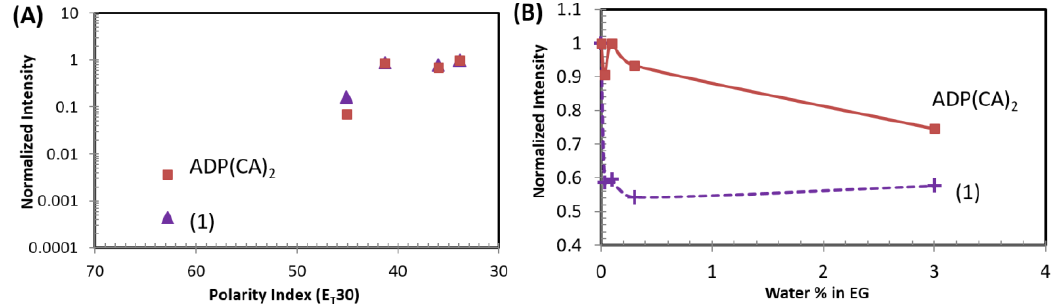
Figure 2. ( A ) Polarity-dependent fluorescence intensity of ADP(CA) 2 and Compound ( 1 ); Five solvents with different polarity index [28] were employed, which are, from left to right, water (62.8), dimethyl sulfoxide (DMSO, 45.1), 1,2-dichloroethane (41.3), 1,4-dioxane (36) and toluene (33.9). ( B ) Fluorescence intensity of ADP(CA) 2 and Compound ( 1 ) in a water/ethylene glycol mixture with different compositions; Excitation: 655 nm; Emission filter: 711/25 band-pass; Laser energy: 50 pJ ( A ) and 140 pJ ( B ); EG: ethylene glycol.